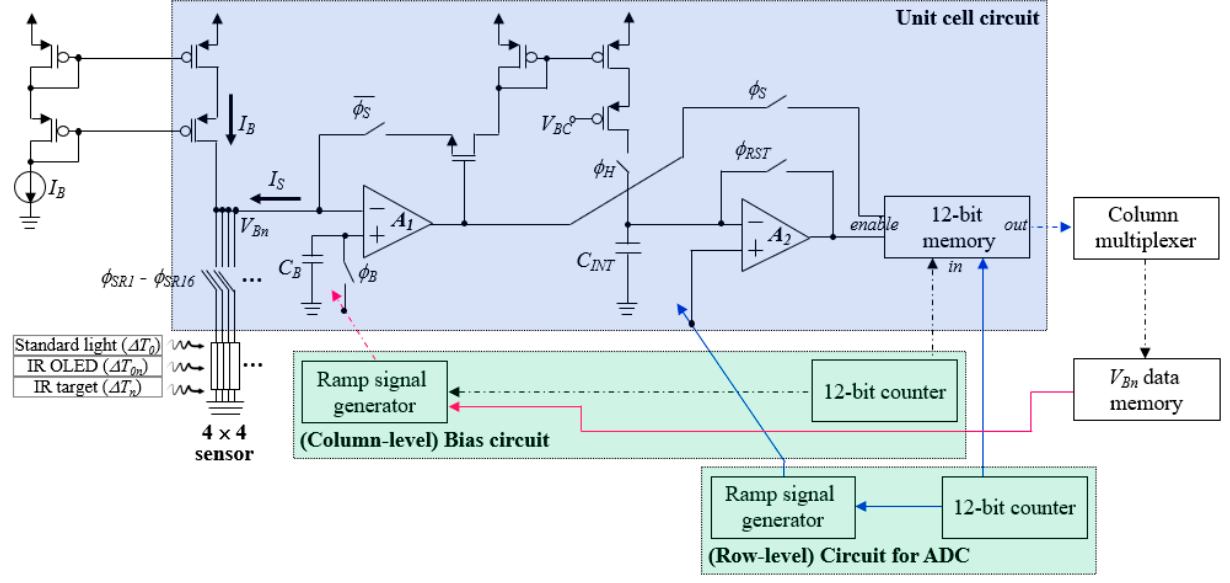
Figure 4. Schematic of the unit cell circuit for the proposed ROIC.